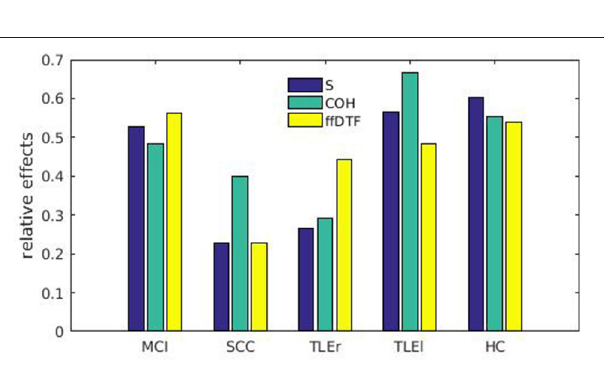
FIGURE 3 | Relative effects for all measures of interaction sorted by groups. Relative effects are given for spectrum (blue), coherence (green), and full frequency directed transfer function (yellow). MCI, mild cognitive impairment; SCC, subjective cognitive complaints; TLEr, right lateralized temporal lobe epilepsy; TLEl, left lateralized temporal lobe epilepsy; HC, healthy controls. The relative effects indicate the probability that a randomly chosen participant from one group exhibits a larger reliability of a specific measure of interaction than a randomly chosen participant from all